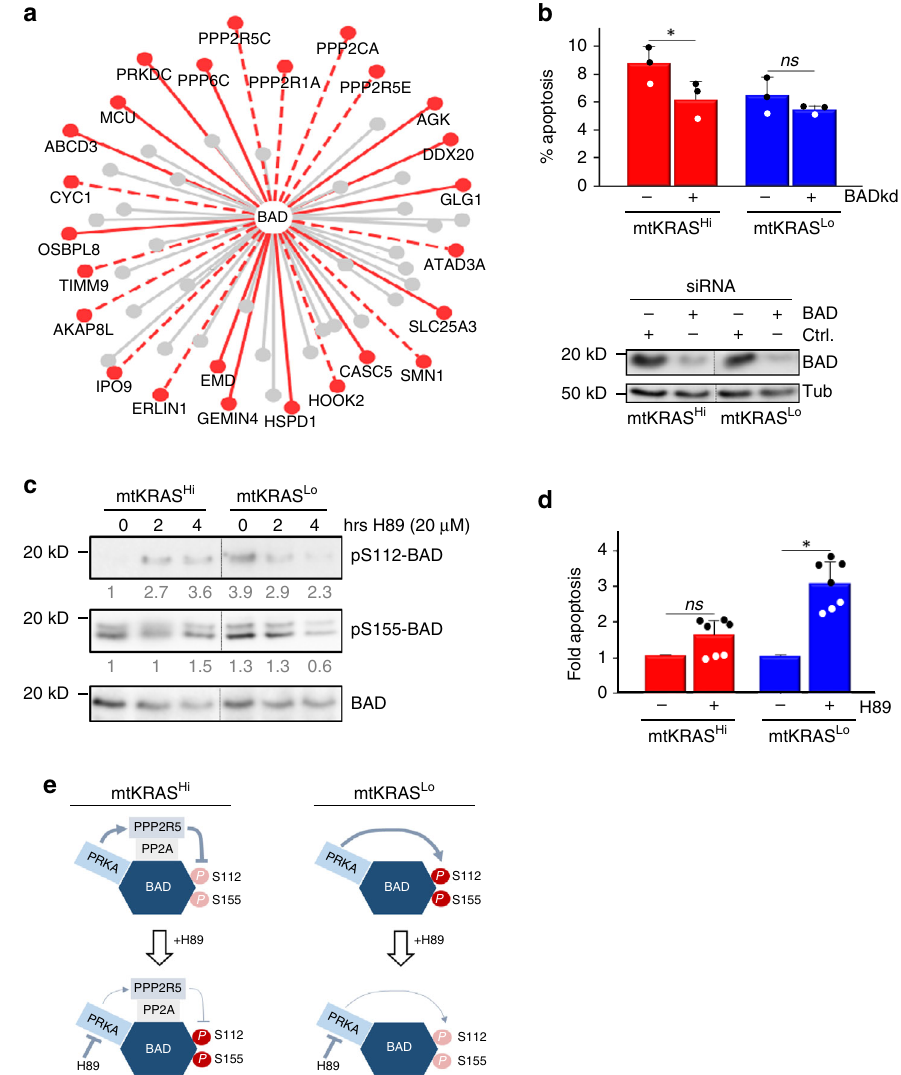
Fig. 4 Differential regulation of BAD protein phosphorylation and its biological effect. a PPI interactions in the BAD complex. Red broken lines, PPIs enhanced in EGFRNet mtKRAS-Hi vs. EGFRNet mtKRAS-Lo ; red solid lines, EGFRNet mtKRAS-Hi exclusive interactions; gray, unchanged interactions. b Knocking down BAD expression signi fi cantly reduces apoptosis in mtKRAS Hi but not mtKRAS Lo cells. Apoptosis was measured 24 h post treatment. Ctrl., untargeted siRNA; BADkd, BAD speci fi c siRNA. The reduction of BAD protein expression was assayed by Western blotting using tubulin (Tub) as loading control. Apoptosis assays represent three independent experiments; error bars are SD, and * means signi fi cant ( P < 0.05) according to Student ’ s t -test; ns , not signi fi cant. c mtKRAS Hi and mtKRAS Lo cells were treated with the PRKA inhibitor H89 as indicated before BAD phosphorylation at S112 and S155 were assessed by Western blotting using phospho-speci fi c antibodies. Numbers below lanes represent BAD phosphorylation normalized to total BAD protein expression. Samples shown in b and c are from the same Western blots, where irrelevant lanes were removed as indicated by vertical lines. d Apoptosis in response to 20 μ M H89 treatment was assessed as in a . The data represent two independent experiments with 3 and 4 biological replicates, respectively. Error bars are SD, and * means signi fi cant ( P < 0.05) according to Student ’ s t -test; ns, not signi fi cant. e A proposed model of the differential